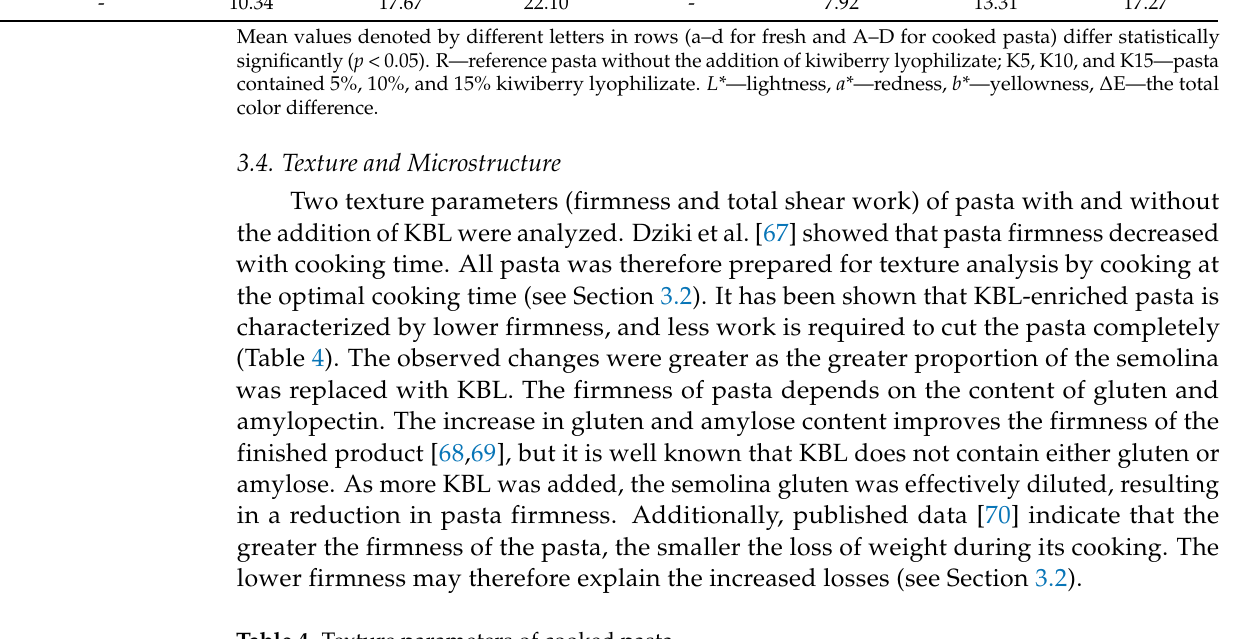
Table 4. Texture parameters of cooked